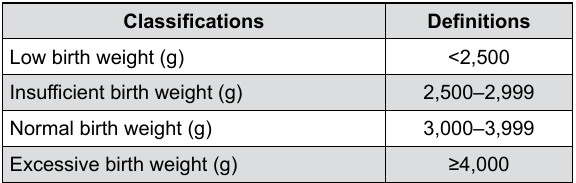
Figure 1- Definitions for infants’ weight at